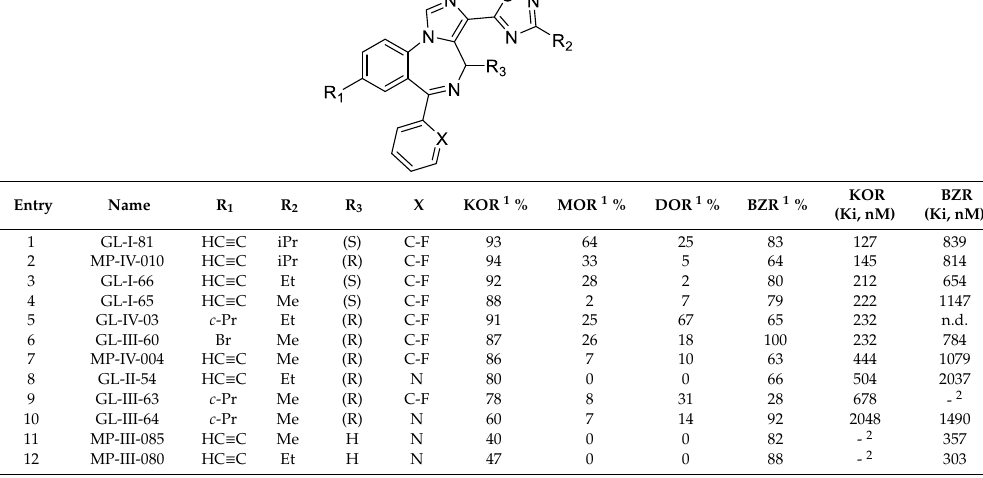
Table 4. Opioid and benzodiazepine receptor binding of imidazodiazepine